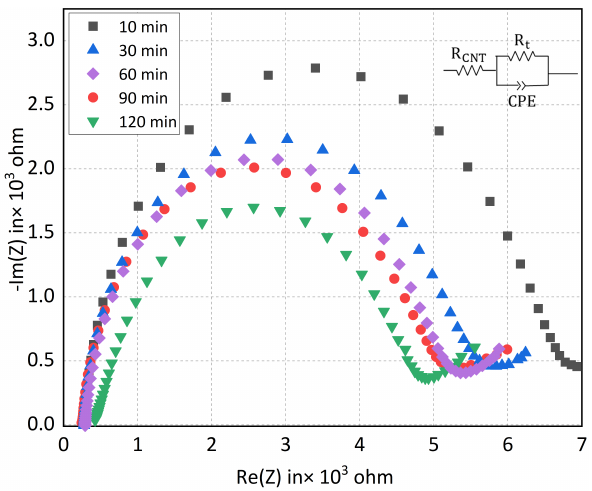
Figure 11. Nyquist plot of modified electrode based on fMWCNT/Toluene dispersion. Initially, fMWCNT are formed as clusters due to Van-der-Waals forces and the distance between the clusters is high. During the sonication, fMWCNT clusters break down as individual fMWCNT where the distance between the fMWCNT reduces leading to a reduced tunneling resistance (R t ). This can be seen in the Figure 11, increasing the sonication time a comprehensive decrease in the radius of the quasi-semicircle, which means that there is a decrease in tunneling resistance (R t ) due to the distance between the fMWCNT reduces during their unbundling